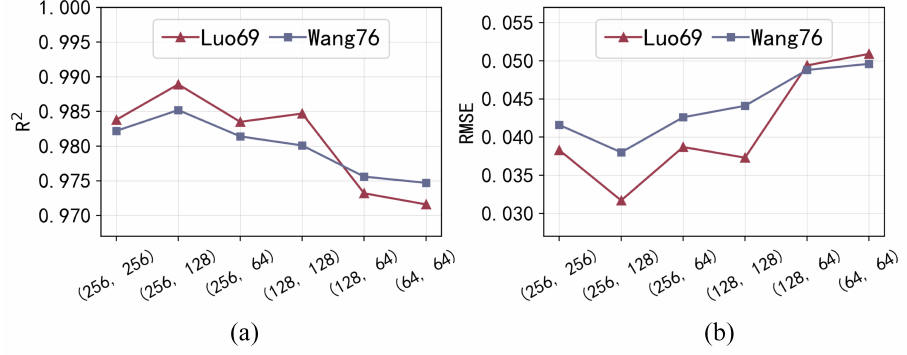
Figure 19. The number selection experimental results on ( a ) R 2 and ( b ) RMSE for hidden layer cells. (5) Network performance